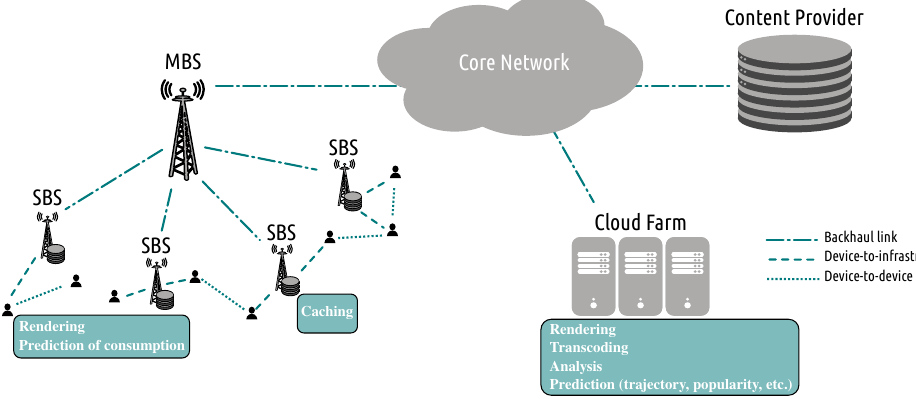
Figure 2. Communication